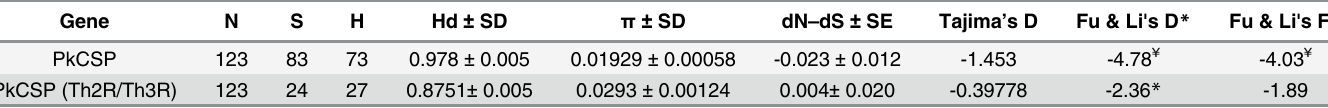
Table 2. Estimates of DNA sequence polymorphism and test of neutrality at the nonrepeat terminals and Th2R/Th3R epitope region of P . knowlesi CSP gene. N = total number of sequences; S = segregating sites; H = number of haplotypes; Hd = haplotype diversity; π = observed average pairwise nucle- otide diversity; dN – dS = rate of nonsynonymous mutations minus rate of synonymous mutations, Gene